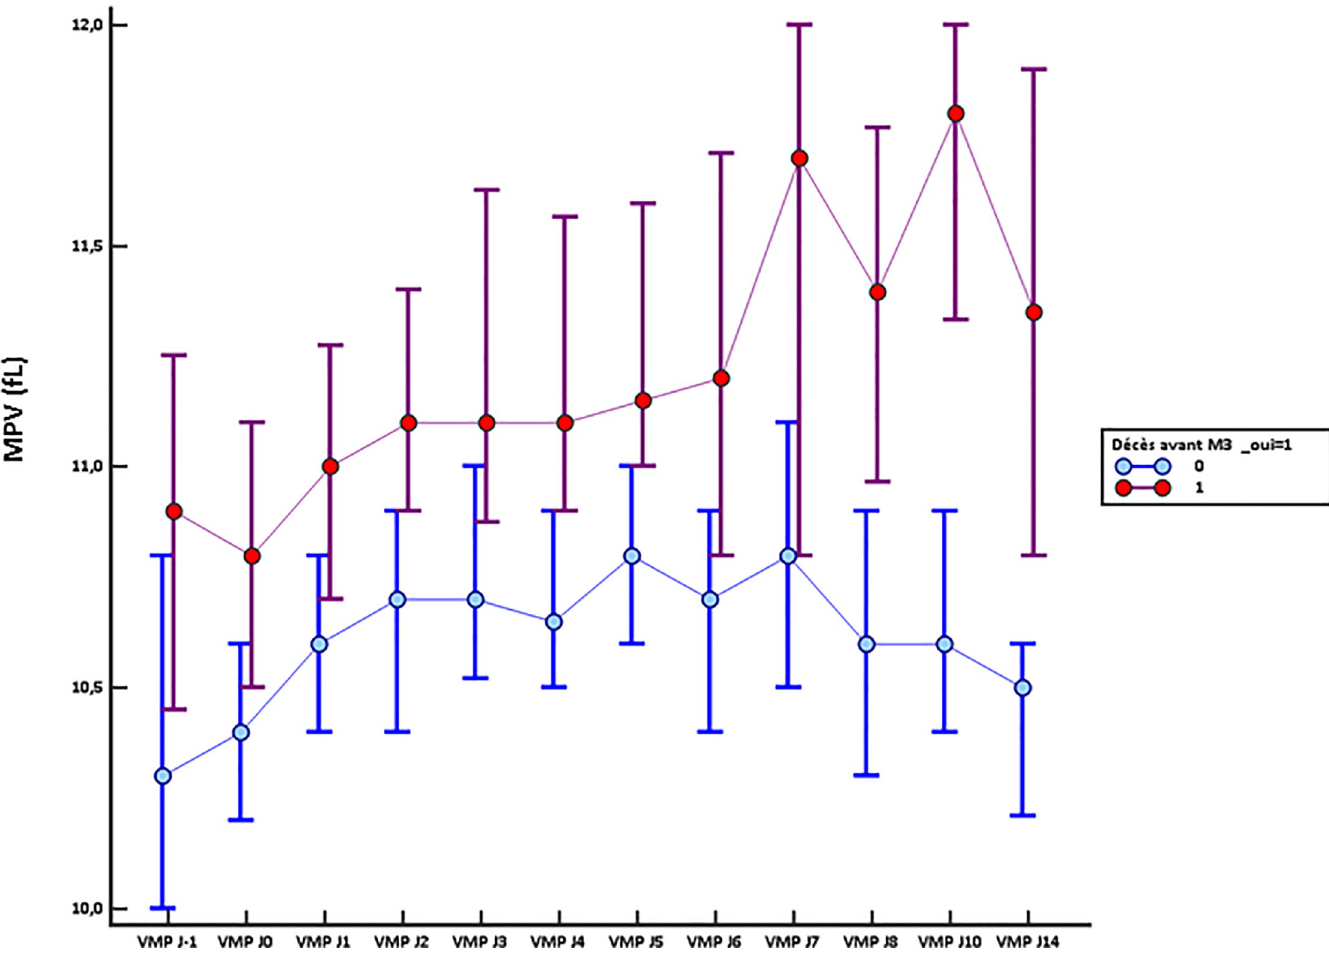
Fig 2. Comparison of MPV kinetics during 15 days according to 90-day